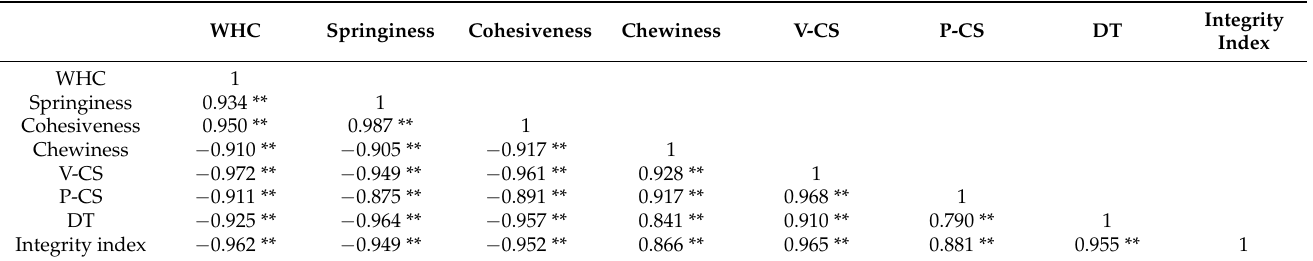
Table 3. Pearson correlation matrix of physical properties for low-moisture meat analogs.